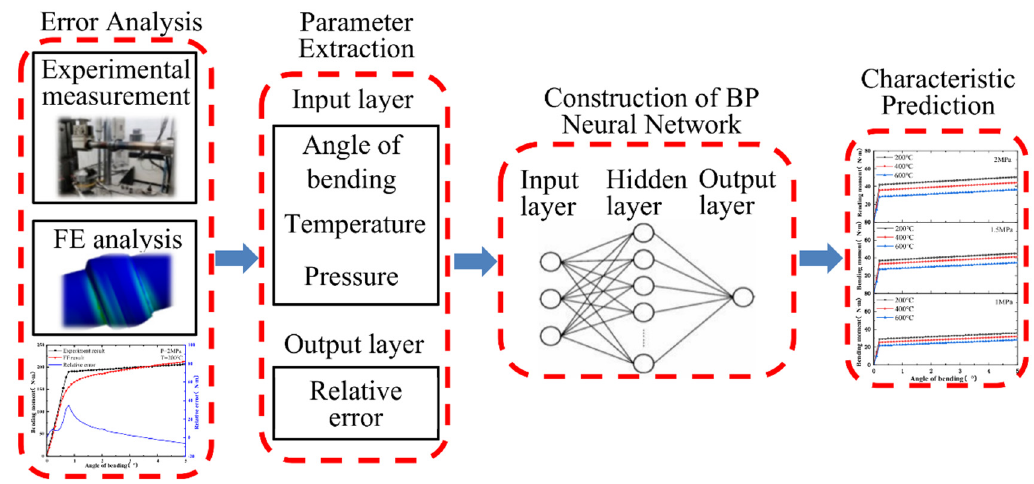
Figure 8. Correction method based on the BP neural network.